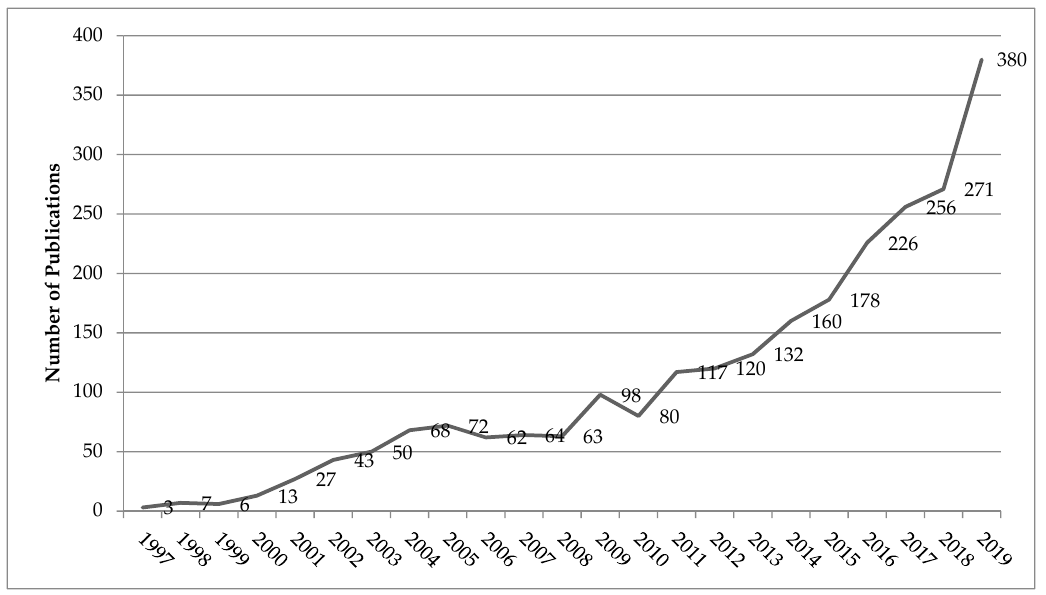
Figure 2. Annual distribution of the number of articles across the period studied (1997–2019).